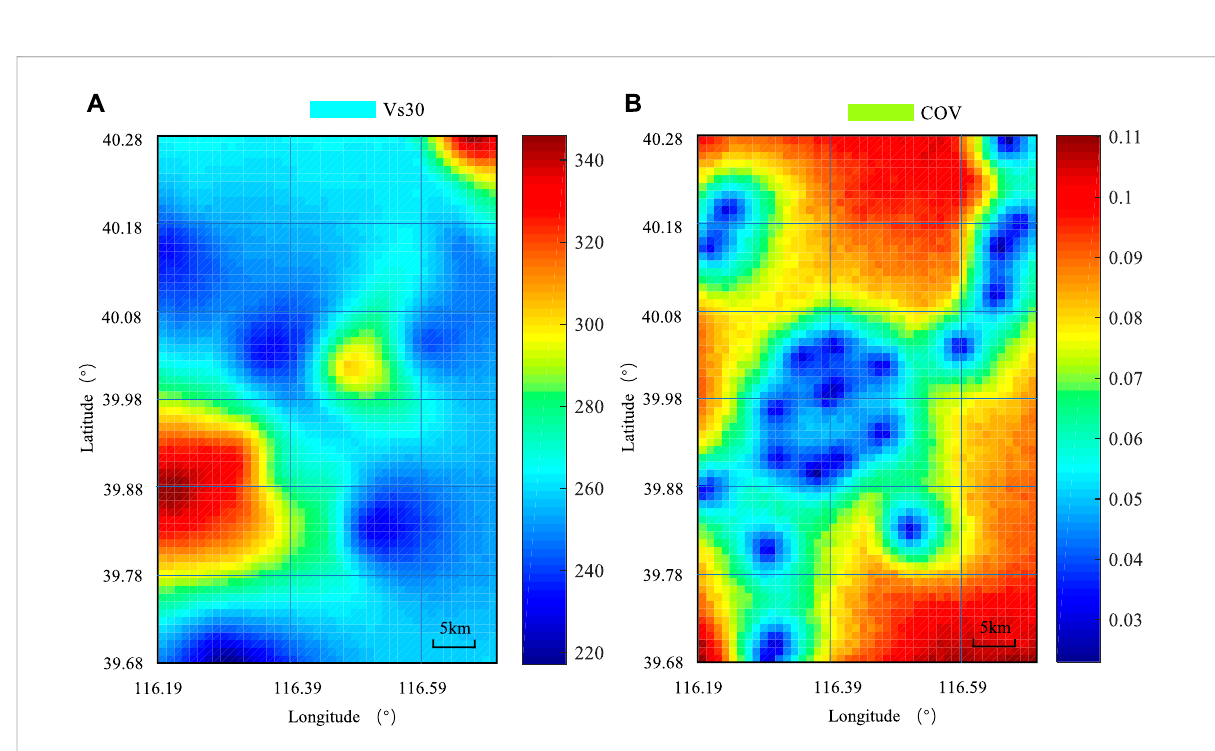
FIGURE 7 Expected V s30 values and associated uncertainties (coef fi cient of variations) in the Beijing area. (A) Map of average V s30 ; (B) Map of COV of V s30